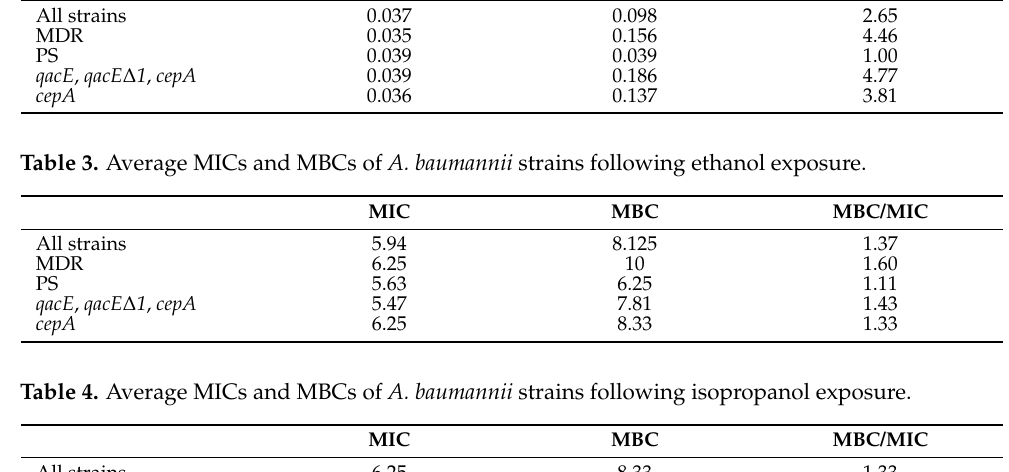
Table 2. Average MICs and MBCs of A. baumannii strains following bleach exposure. All strains